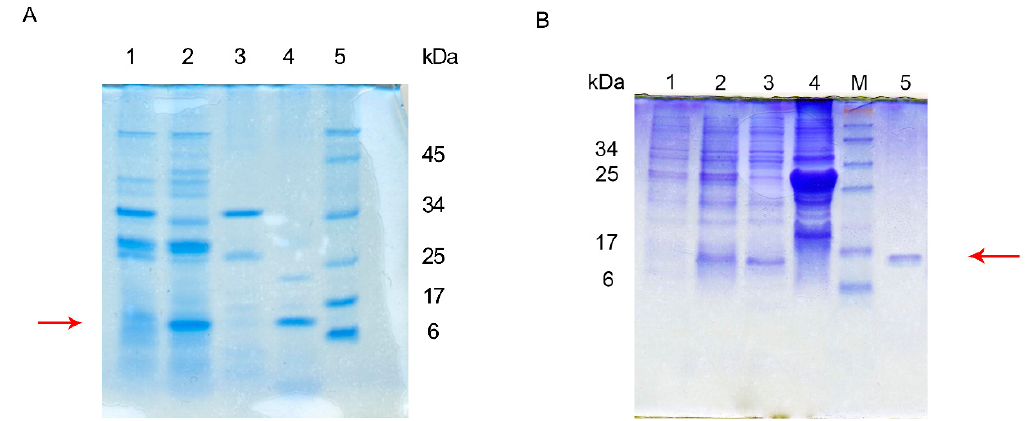
Figure 2. Recombinant expression and purification of hepcidins. ( A ) Lane 1, before induction; Lane 2, after induction; Lane 3, flow-through faction using the FPLC (Fast protein liquid chromatography) purification system. Lane 4, purified Hamp1. ( B ) Lane 1, before induction; Lane 2, after induction; Lane 3, supernatant fraction after sonication; Lane 4, pellet fraction after sonication; Lane 5, purified Hamp2.